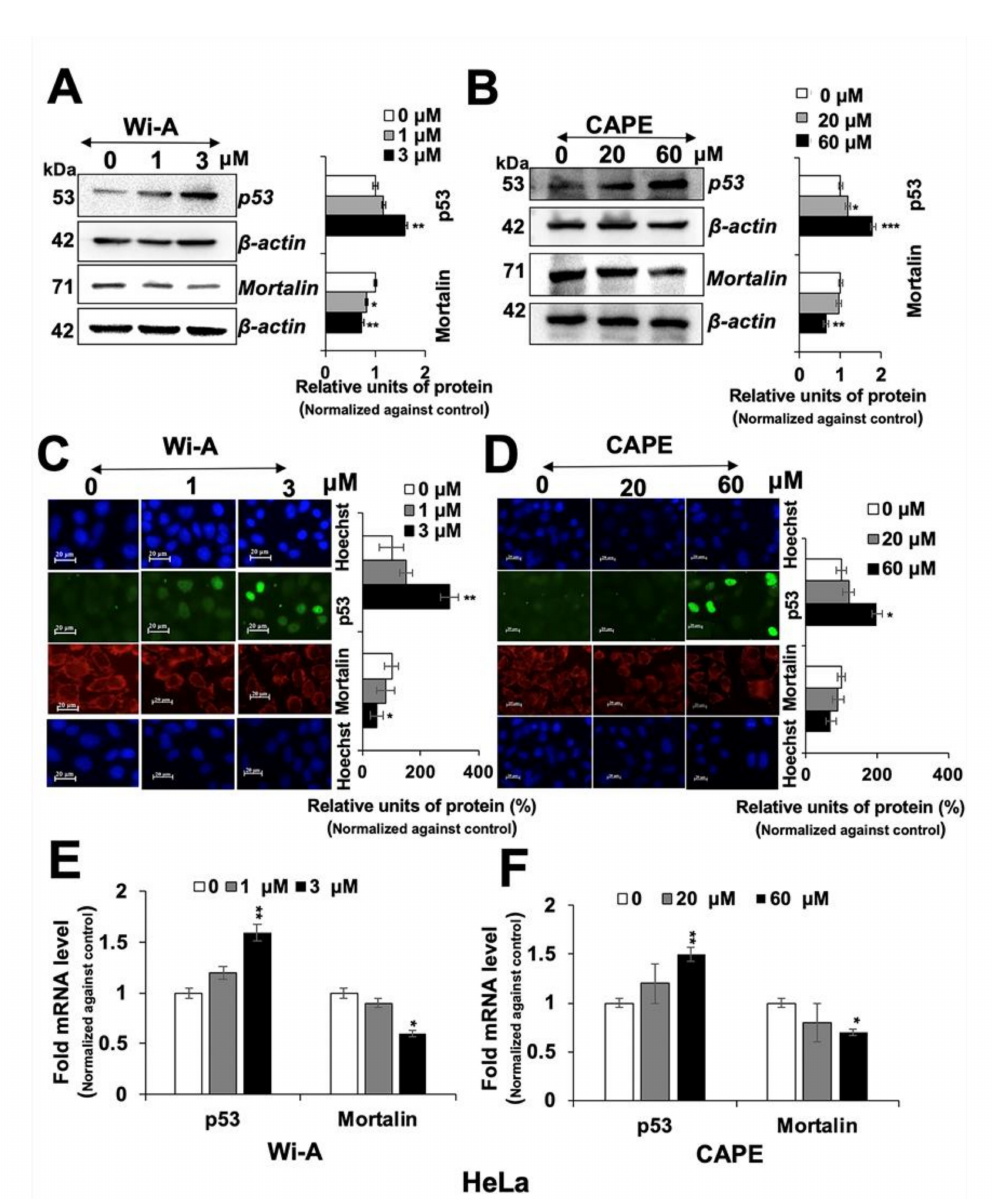
Figure 2. Withaferin A (Wi-A) and ca ff eic acid phenethyl ester (CAPE) caused downregulation of mortalin and activation of tumor suppressor p53 protein. Wi-A- and CAPE-treated cells showing dose-dependent decrease in mortalin and increase in p53 protein levels in HeLa cells as detected by Western blotting ( A , B ) and immunostaining ( C , D ); Scale bar–20 µ M. Dose-dependent increase in p53 mRNA and decrease in mortalin mRNA were detected in cells treated with Wi-A ( E ) and CAPE ( F ). Data were normalized against the control and plotted as fold or percent di ff erence as indicated. Each data set represents the mean ± SD for at least three independent biological replicates. Statistical significance was defined as p -values (*) where * < 0.05, ** < 0.01 and *** < 0.001 represent significant, very significant and highly significant,